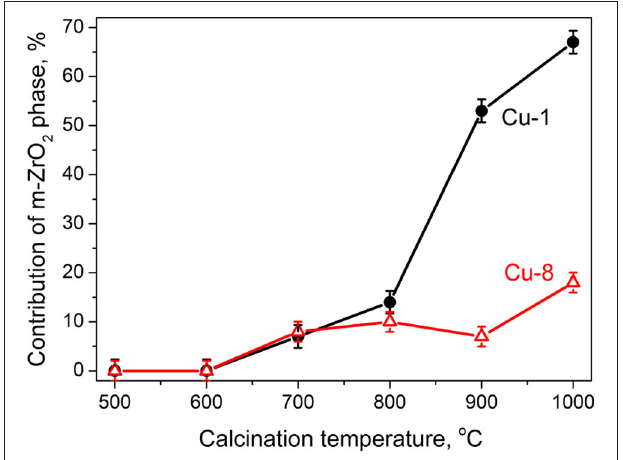
FIGURE 2 | Relative contribution of monoclinic phase for Cu-1 (circle symbols) and Cu-8 (triangle symbols) powders calcined at different temperatures estimated from XRD data.